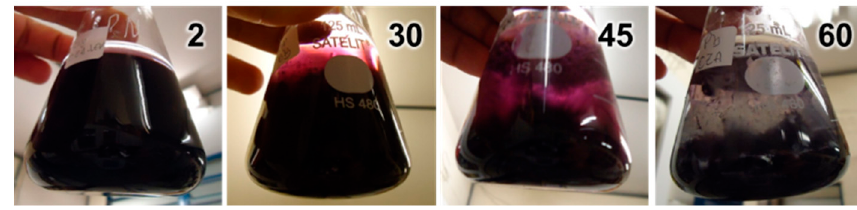
Figure 1. Erlenmeyer flasks containing the filamentous fungus Cladosporium sphaerospermum immersed in a colloidal suspension of gold nanoparticles after 2, 30, 45, and 60 days of inoculation.